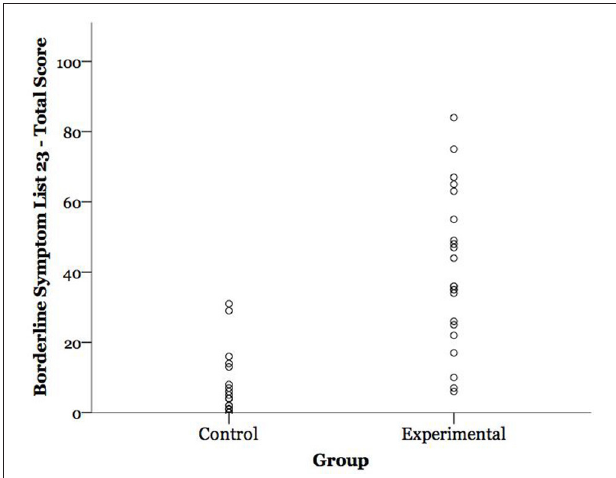
FIGURE 1 | Participants’ borderline personality disorder (BPD) symptom severity scores by group. BPD symptom severity is expressed as participants’ total score on the Borderline Symptom List 23 (BSL-23); possible range =